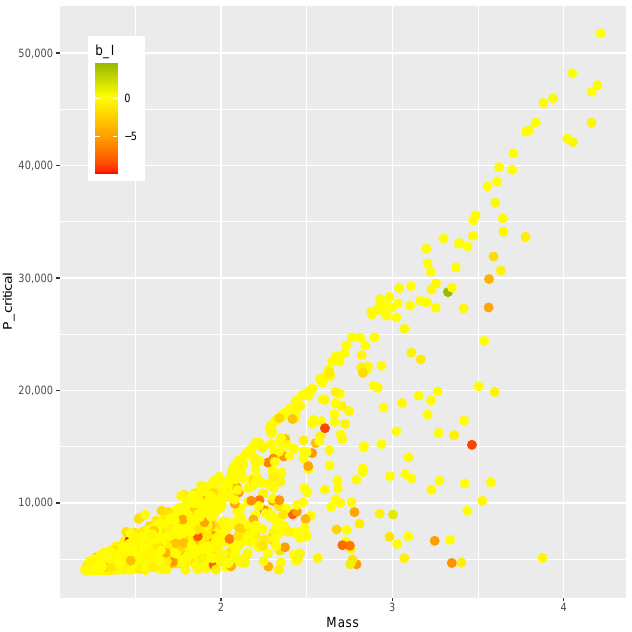
Figure 17. Mass m , P critical , and b I of the